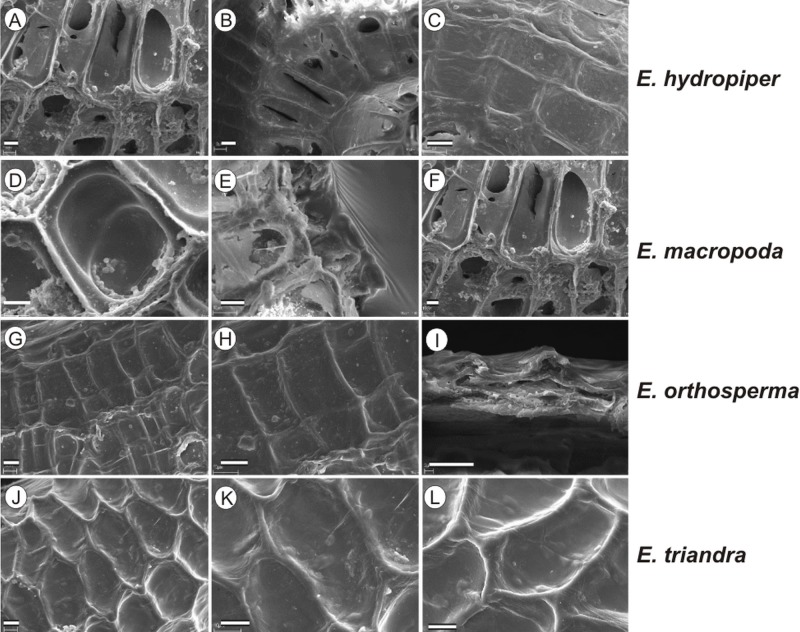
The diversity in seed coat micromorphology of Elatine hydropiper (a - hydHu, b, c - hydPL1); E. macropoda (a, b -macIT; c–macSP), E. orthosperma (a, b -ortCZ; c - ortFI1), E. triandra (a–triHU; b, c–triPL1).Scale bar = 10 µm. For acronyms, see Table 1. (A–B) E. hydropiper; (D–F) E. macropoda; (G–I) E. orthosperma; (J–L) E. triandra.